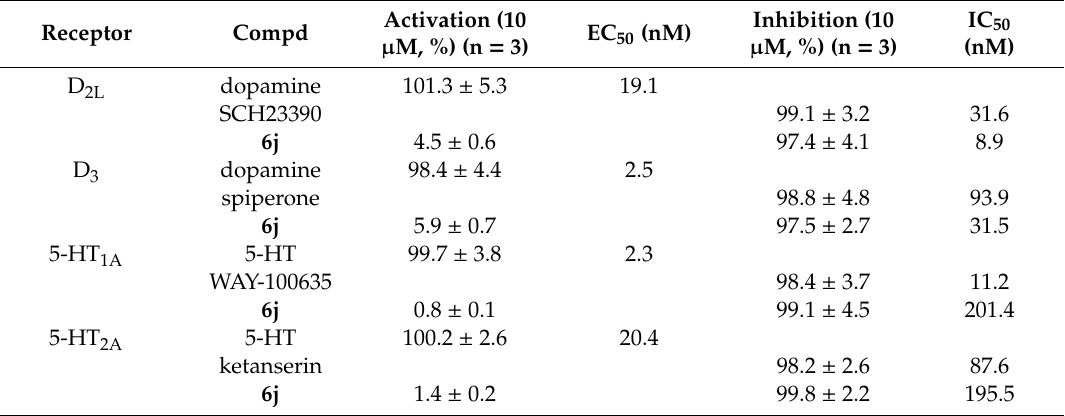
Table 5. Activities of Compound 6j and Reference Compounds to D 2L , D 3 , 5-HT 1A , 5-HT 2A